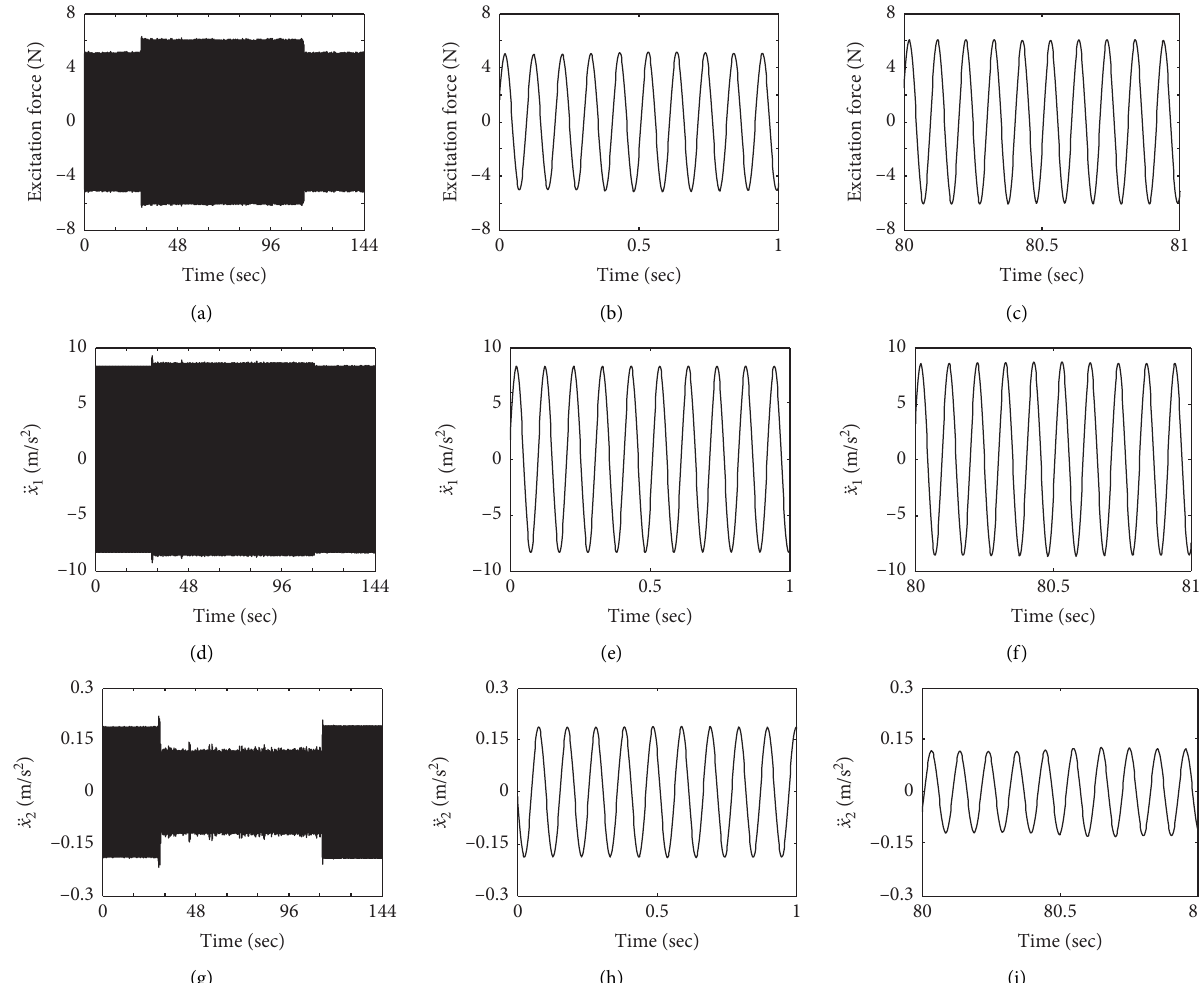
Figure 7: Measured time histories of excitation force and system accelerations when Ω � 9 . 75 Hz (for t < 29s and t > 113s, α � − 0 . 4, α � − 0 . 33, and τ � 50ms): (a) excitation force; (d) absorber; (g) primary system; (b, c) zoom of (a); (e, f) zoom of 29s ≤ t ≤ 113s, α 1 2 2 (d); (h, i) zoom of